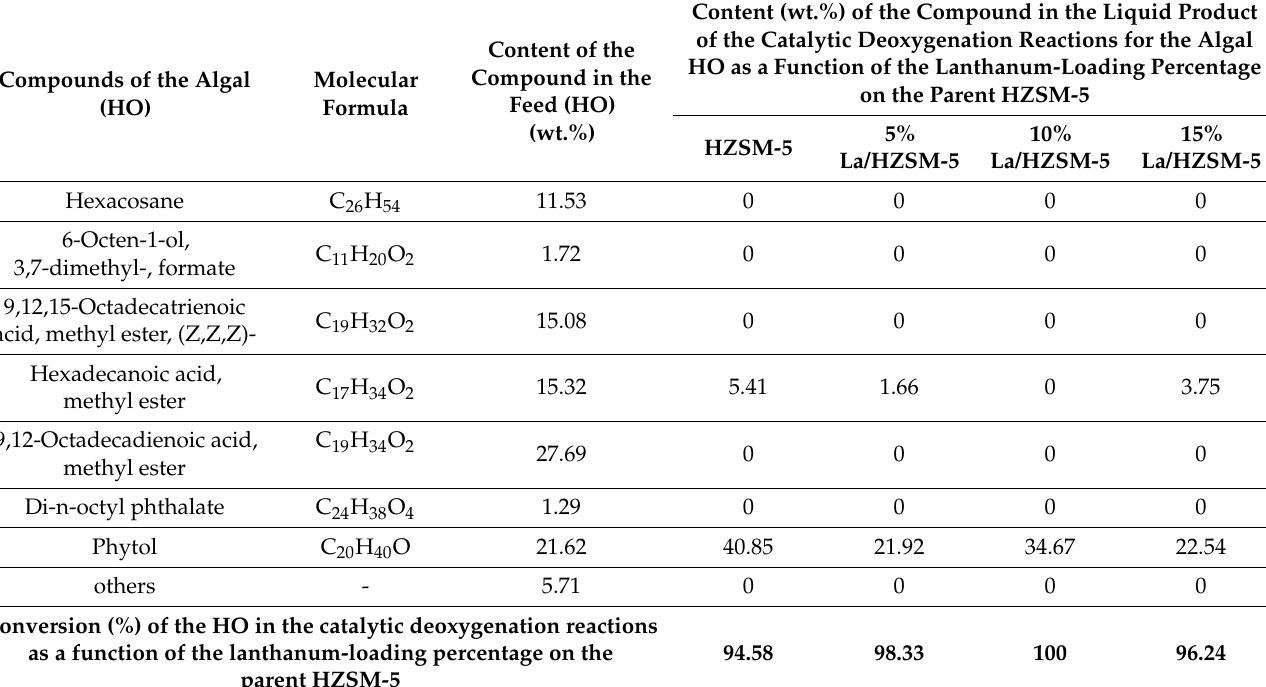
Figure 9. Conversions of the algal (HO) of the catalytic deoxygenation reactions over the parent HZSM-5, 5%La/HZSM-5, 10% La/HZSM-5, and 15%La/HZSM-5 at operating conditions of (batch reactor, 300 °C, 1000 rpm, 7 bar of N 2 , the catalyst to the algal HO ratio = 15% (wt.%) and 6 h). Table 3. Mass balances (wt.%) of the algal HO compound in the feed, and the compounds of liquid products for the conversion of HO over HZSM-5, 5%La/HZSM-5, 10% La/HZSM-5, and